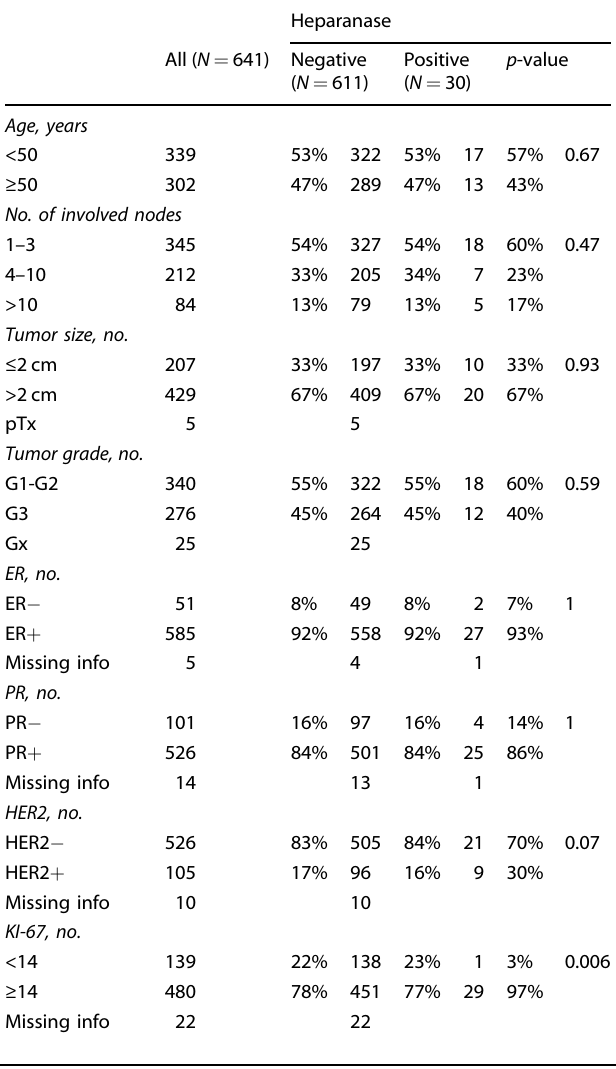
Table 1. Association between heparanase (by IHC) expression and pathological clinical parameters in ER + breast